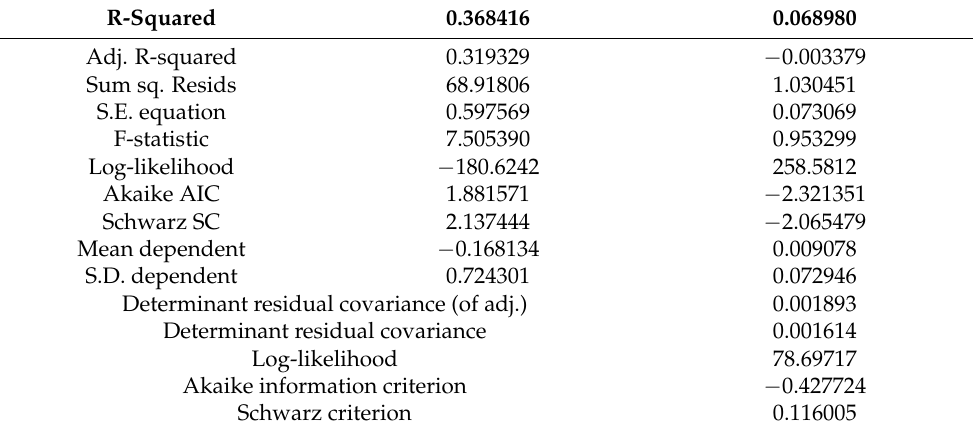
Table 6. Vector error correction model (VECM) for 6 lags-short run